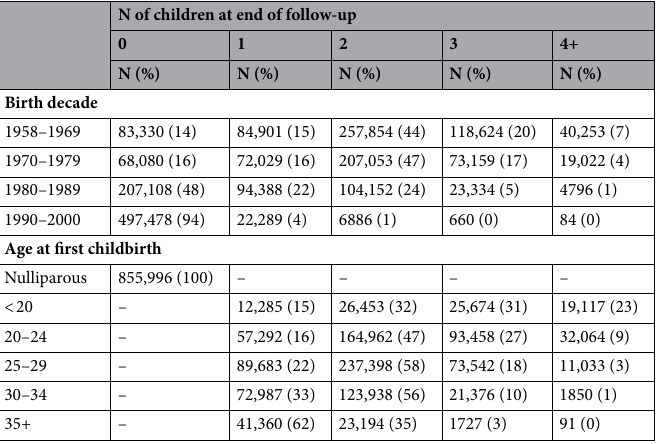
Table 1. Descriptive characteristics of the women included into the study. The percentages reported in this table are row percentages.